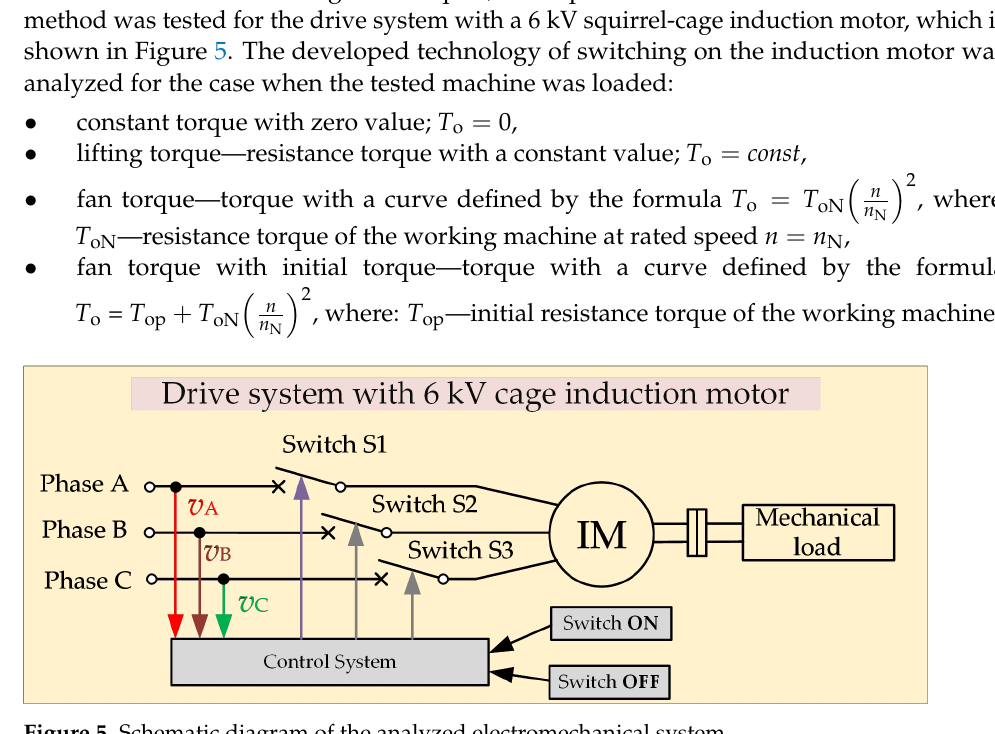
Figure 5. Schematic diagram of the analyzed electromechanical